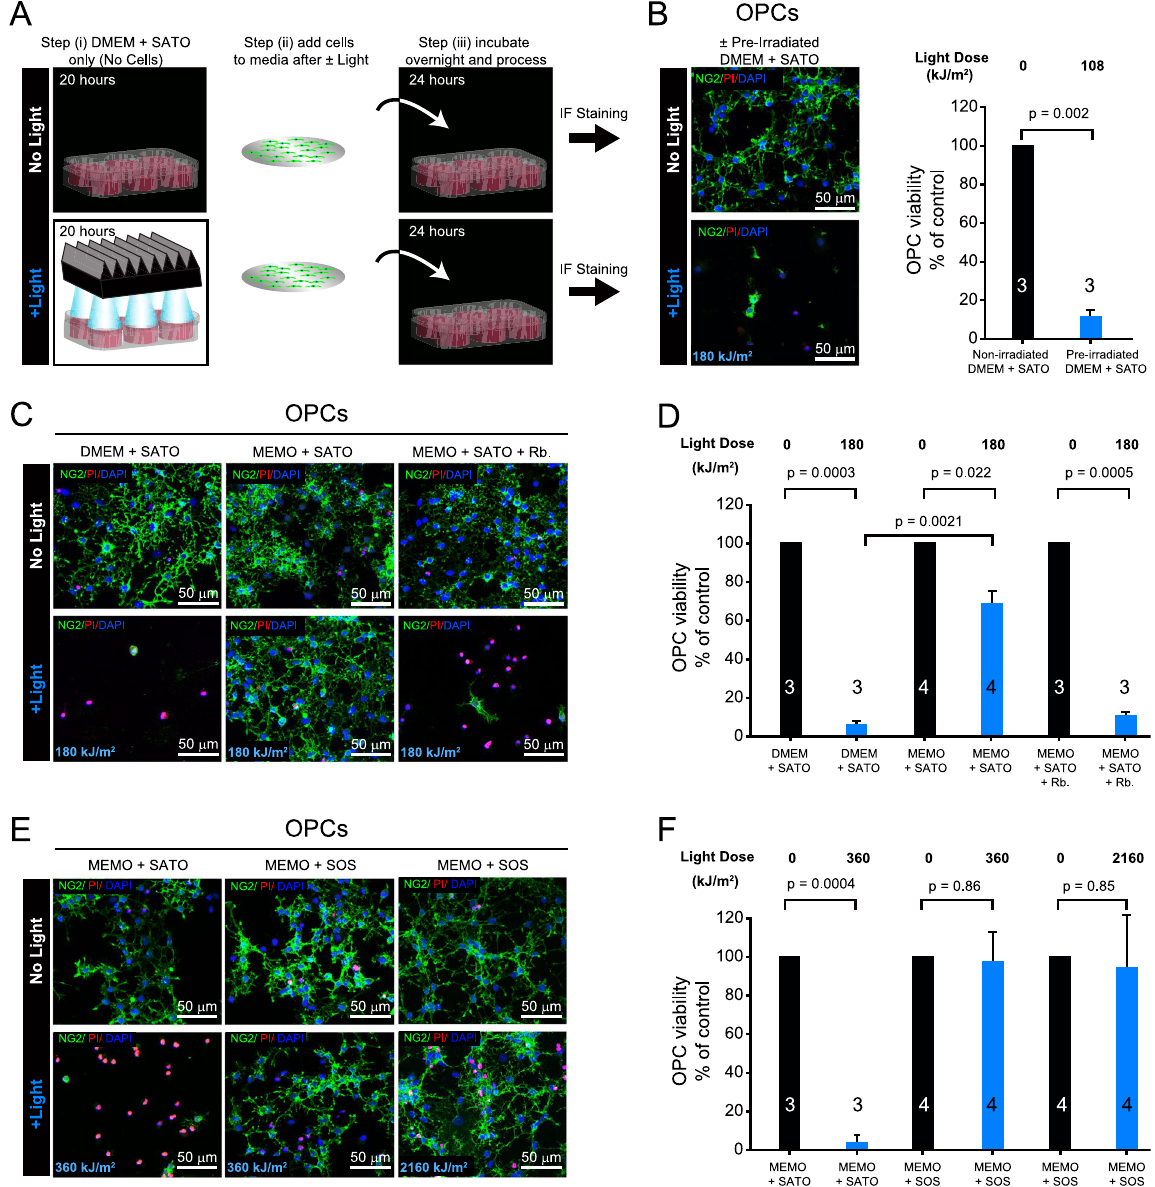
Figure 2. In vitro photo-toxicity can be resolved with a new culture medium. ( a ) Setup of experiment to test media for photo-reactive components. Step (i) media is treated ± light stimulation ( W = 0.3 mW/mm 2 , t = 5 ms and f = 1 Hz) for 20 hours delivering 108 kJ/m 2 of light, step (ii) after which viable cells are placed in ± pre-irradiated media for 24 hours before step (iii) analysis by PI exclusion assay. ( b ) Viabilities of OPCs 24 hours after placement into DMEM + SATO treated ± light (108 kJ/m 2 ). Note: the robust loss of OPC viability in pre-irradiated media is similar to irradiating cells directly with light (see Fig. 1h). ( c and d ) Significant improvement (p = 0.0021) of OPC viability in photo-inert media MEMO + SATO compared to DMEM + SATO when treated with light (180 kJ/m 2 ), but both conditions retain significant loss of viabilities compared to cells kept in dark (p = 0.0003 and p = 0.022 respectively), and addition of riboflavin (Rb.), a component absent in MEMO, restores highly significant loss (p = 0.0005) of OPC viability when treating cells with light. ( e and f ) Increasing light dose to 360 kJ/m 2 induces robust loss of OPC viability in MEMO + SATO, however, combining MEMO + SOS protects OPC viabilities during light doses of 360 kJ/m 2 and up to 2160 kJ/m 2 ( W = 0.6 mW/ mm 2 , t = 0.5 ms and f = 10 Hz), a dose 20 fold greater than the 108 kJ/m 2 dose that induced almost complete loss of OPC viability in standard conditions of DMEM + SATO (see Fig. 1h). All above histograms are normalized to controls with data representing means ± s.e.m. of a number of biological replicates (value within or above each histogram) and p values from Student’s two tailed unequal variance t-test. Black and blue histograms represent conditions kept in the dark or exposed to light respectively. Light doses in kJ/m 2 are shown above histograms and as insets within representative images of irradiated experiments. Cell culture media conditions are described above images and under respective